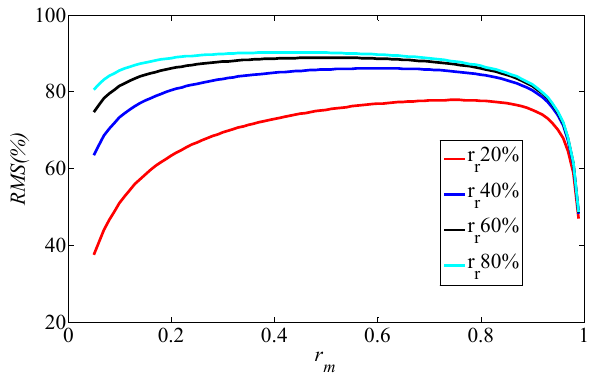
ff ect of mass ratio on control e ff ectiveness: curves of RMS Figure 5. Effect of mass ratio on control effectiveness: curves of RMS . Figure 5. E